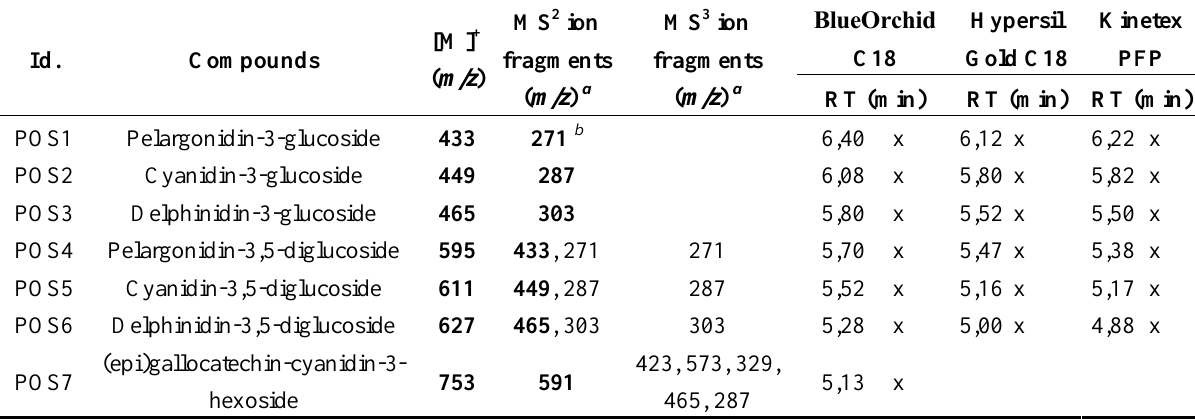
Table 2. Identification of phytochemical compounds by UHPLC-MS n in positive mode by different analytical